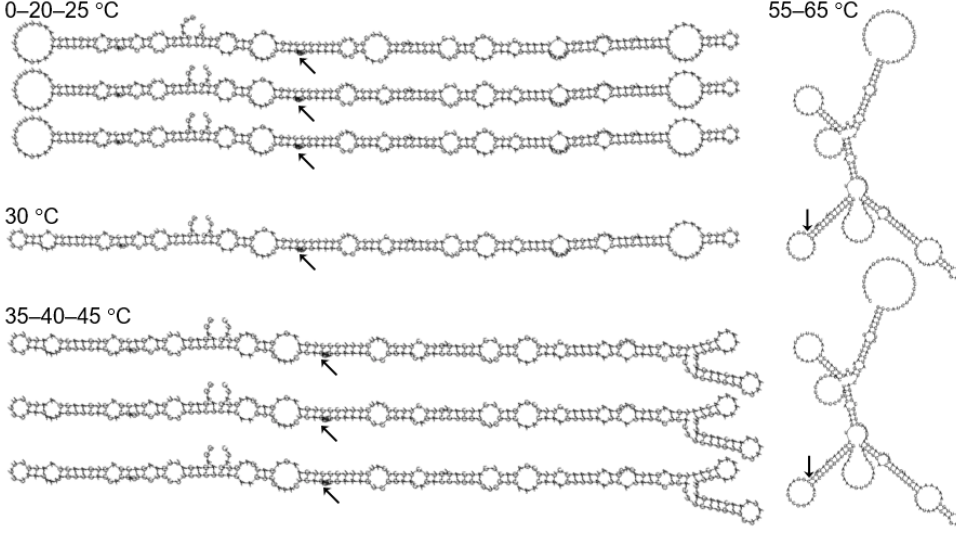
Figure 4. Optimal secondary structures of ASBVd(–) at different temperatures as determined using the RNAfold WebServer. Arrows denote C86, the cleavage site. On the other hand, the centroid secondary structures were unique at each tempera- ture and showed an expected gradual opening of the molecule, although the overall rod- like structure was persistent (Figure 5). Furthermore, the 3D tertiary structure, calculated